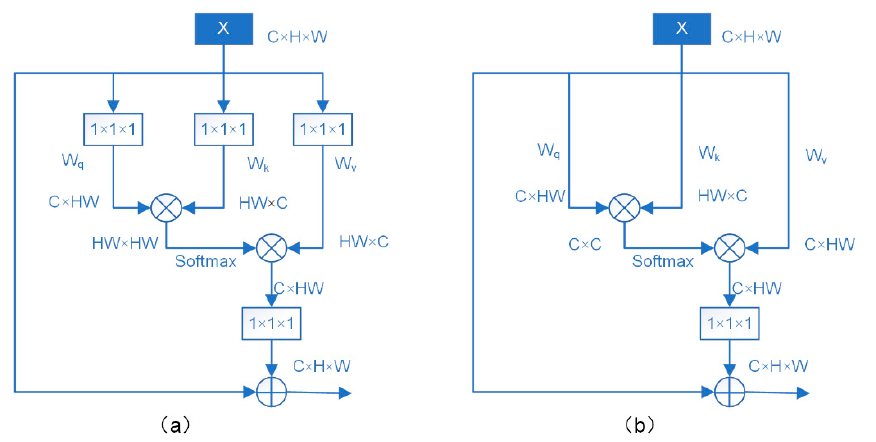
Figure 2. ( a ) Non-local module; ( b ) the channel-base attention module.